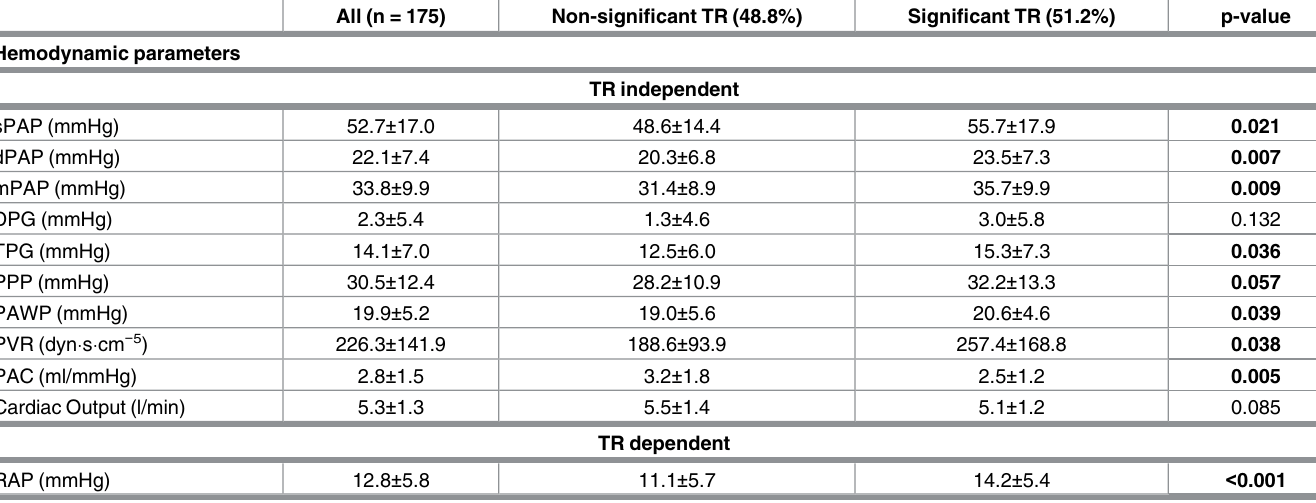
TR indicates tricuspid regurgitation; sPAP, systolic pulmonary artery pressure; dPAP, diastolic pulmonary artery pressure; mPAP, mean pulmonary artery pressure; DPG, diastolic pulmonary vascular pressure gradient; TPG, transpulmonary pressure gradient; PPP, pulmonary pulse pressure; PAWP, pulmonary artery wedge pressure; PVR, pulmonary vascular resistance; PAC, pulmonary arterial compliance; RAP, right atrial